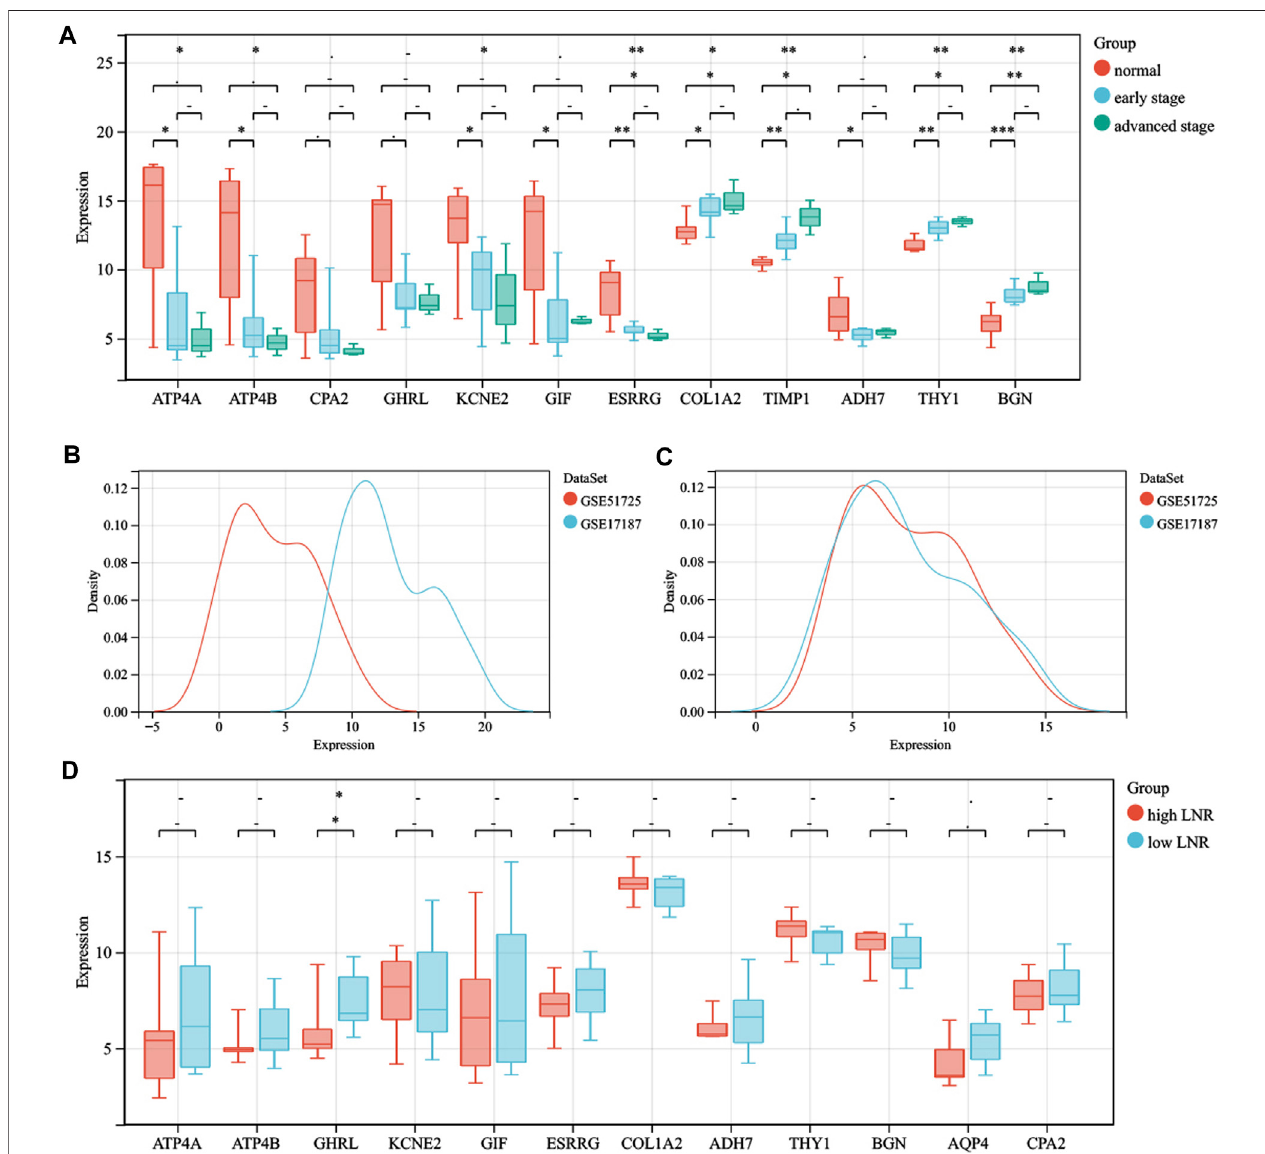
FIGURE 2 | The roles that signi fi cant DEGs play in the oncogenesis, progression, and lymph node metastasis. (A) comparison of the expression levels of ATP4A, ATP4B, CPA2, GHRL, KCNE2, GIF, ESRRG, COL1A2, TIMP1, ADH7, THY1, and BGN between paracancer tissues, GC tissues with early stage and GC tissues with late stage. (B) gene data before normalization. (C) gene data after normalization. (D) comparison of the expression levels of ATP4A, ATP4B, GHRL, KCNE2, GIF, ESRRG, COL1A2, ADH7, THY1, BGN, AQP4, and CPA2 between GC tissues with high LNR and GC tissues with low LNR. The statistical methods adopted for A and D are the Kruskal – Wallis test and Wilcoxon test, respectively. - , p > 0.05; *, p < 0.05; **, p < 0.01. DEGs, differentially expressed genes; GC, gastric cancer; LNR, lymph node